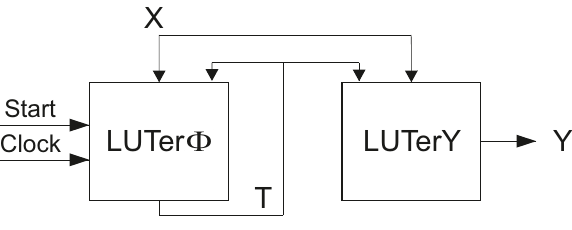
Figure 1. Structural diagram of LUT-based Mealy FSM U 1